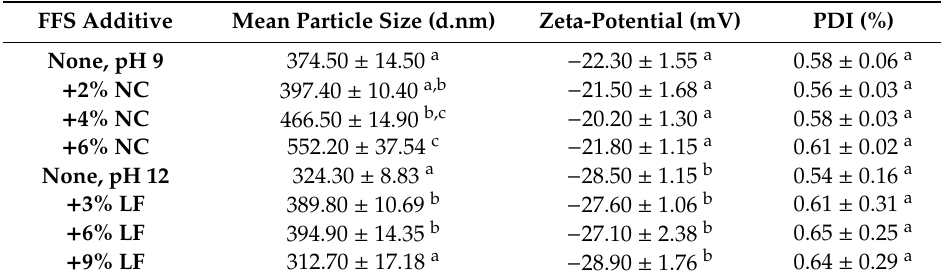
Table 1. Mean particle size, zeta potential and polydispersity index (PDI) of di ff erent hemp protein film forming solutions (FFSs) containing increasing amounts of either nanocrystalline cellulose (NC) or lignin fraction (LF) and prepared at pH 9 and 12, respectively